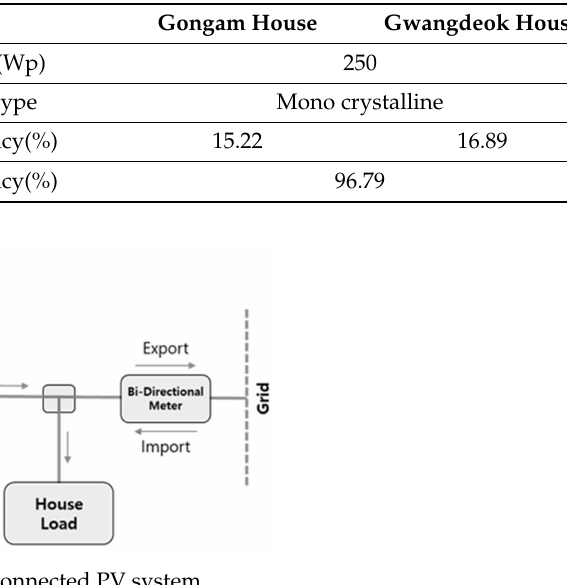
Figure 4. Schematic diagram of grid-connected PV system.